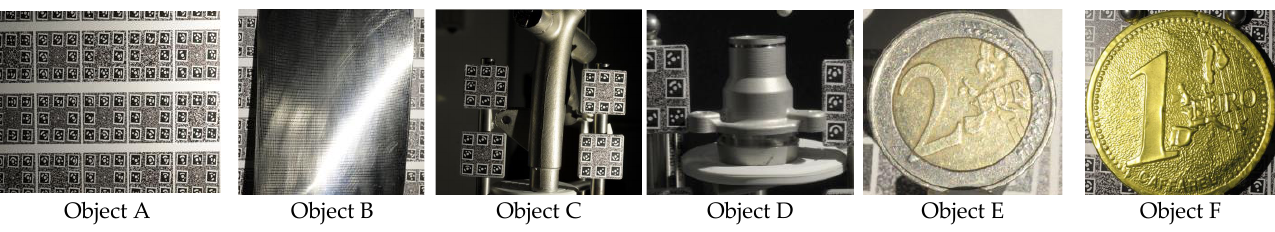
Figure 9. Used objects with their different surface characteristics. Table 1. Objects and acquisitions